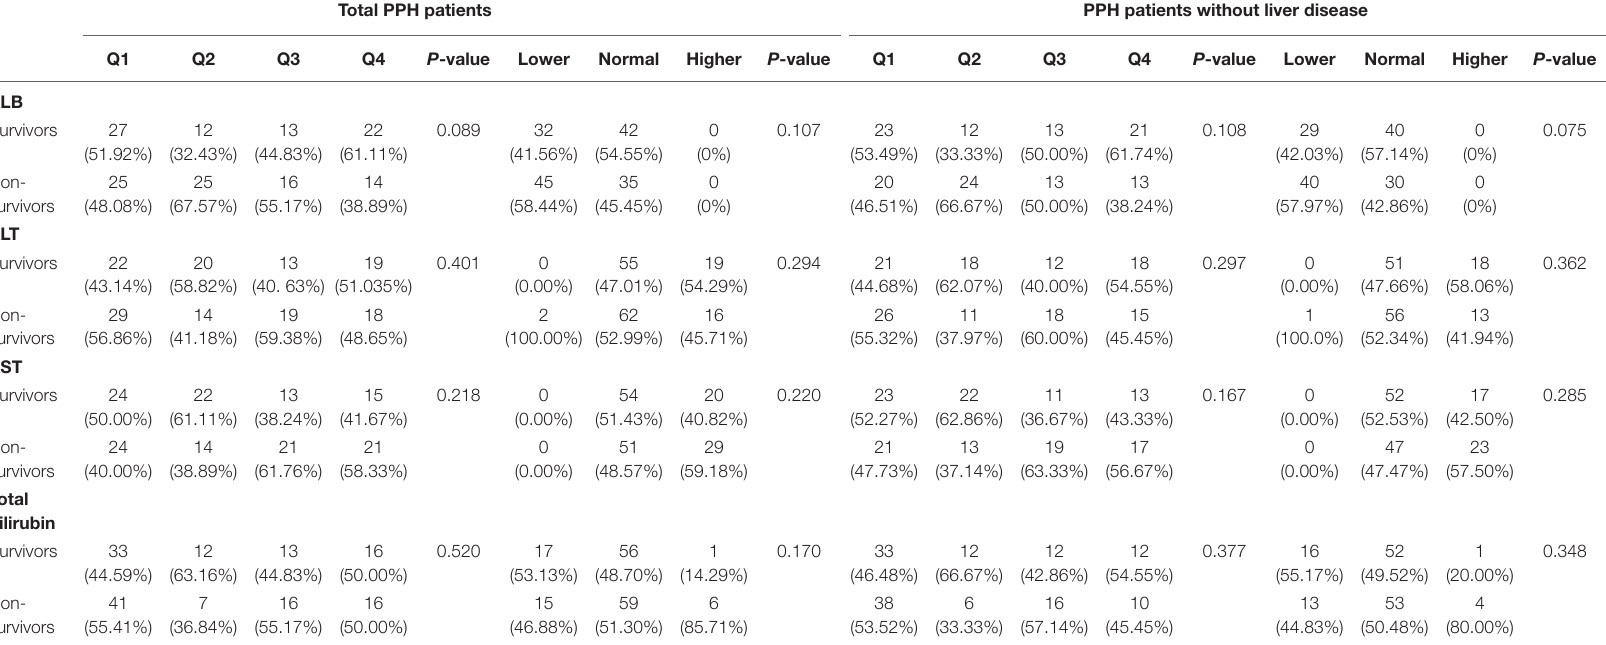
TABLE 5 | The relationship between ALB, ALT, AST, and total bilirubin with 4-year